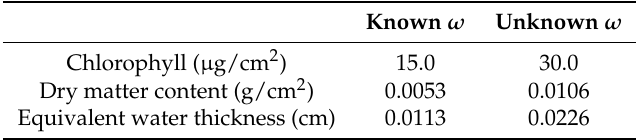
Table 1. Absorption coefficient values for known and unknown ω